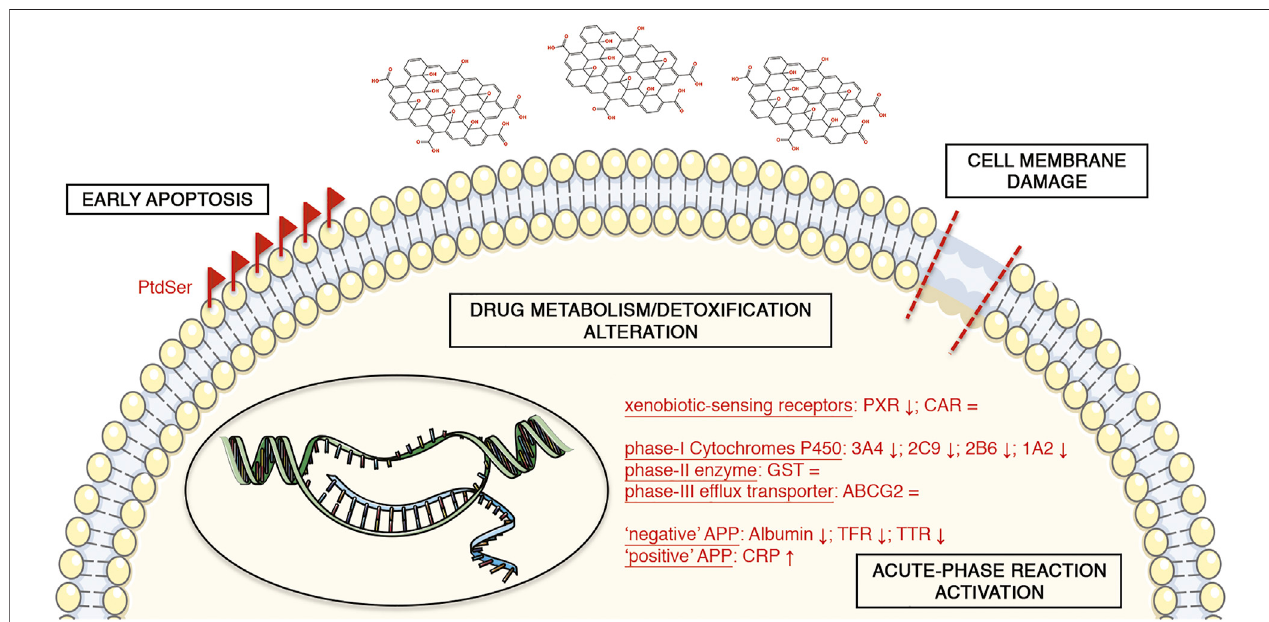
FIGURE 8 | Schematic representation of the GO-induced toxicity in upcyte ® hepatocytes. The symbols “ ↑ ” and “ ↓ ” mean the positive or negative gene expression regulation of the corresponding marker, respectively. The symbol “ = ” indicates no alterations of the corresponding marker. The illustrations of the cell components are from smart.servier.com (published by LES LABORATOIRES SERVIER,